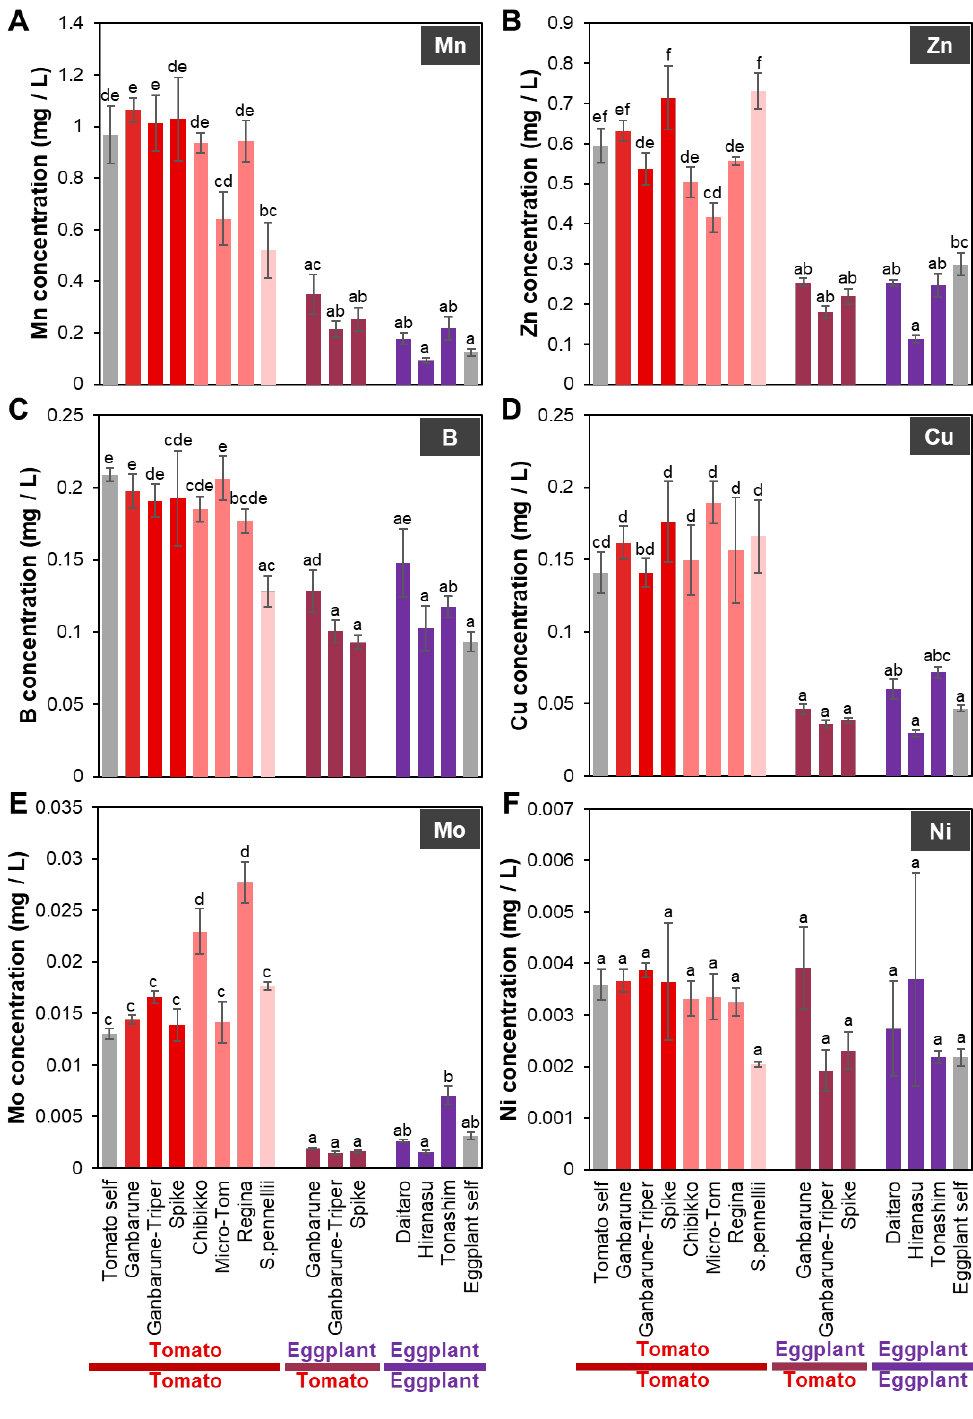
Figure 2. The concentrations of microelements in the xylem exudate of various grafting combinations. The concentrations of Mn ( A ), Zn ( B ), B ( C ), Cu ( D ), Mo ( E ), and Ni ( F ) in the xylem exudate of various grafting combinations. Gray, red, red–pink, pink, red–purple, and purple indicate self-grafted plants, tomato grafted onto various rootstocks of tomato cultivars, tomato grafted onto various dwarf tomato cultivars, tomato grafted onto wild tomato, eggplant grafted onto various tomato cultivars, and eggplants grafted onto various eggplant cultivars, respectively. Different letters indicate significant differences according to the Tukey-Kramer test ( p ≤ 0.05). Values are the means of four replicate samples, and error bars indicate the standard error of four replicate samples.